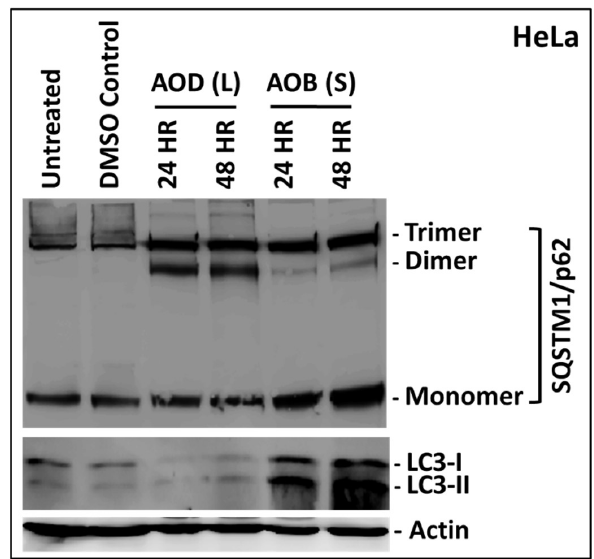
Figure 9. Western blot analysis of HeLa cells treated with 250 µg/mL of A. orientalis dichloromethane leaf (AOD (L)) or n -butanol stem fractions (AOB (S)) for 24 and 48 h. Actin antibody was used as a loading control. Different oligomeric forms of SQSTM1 were observed on the gel, that have been indicated on the side. DMSO C, DMSO control having same amount of DMSO as the test treated sample.